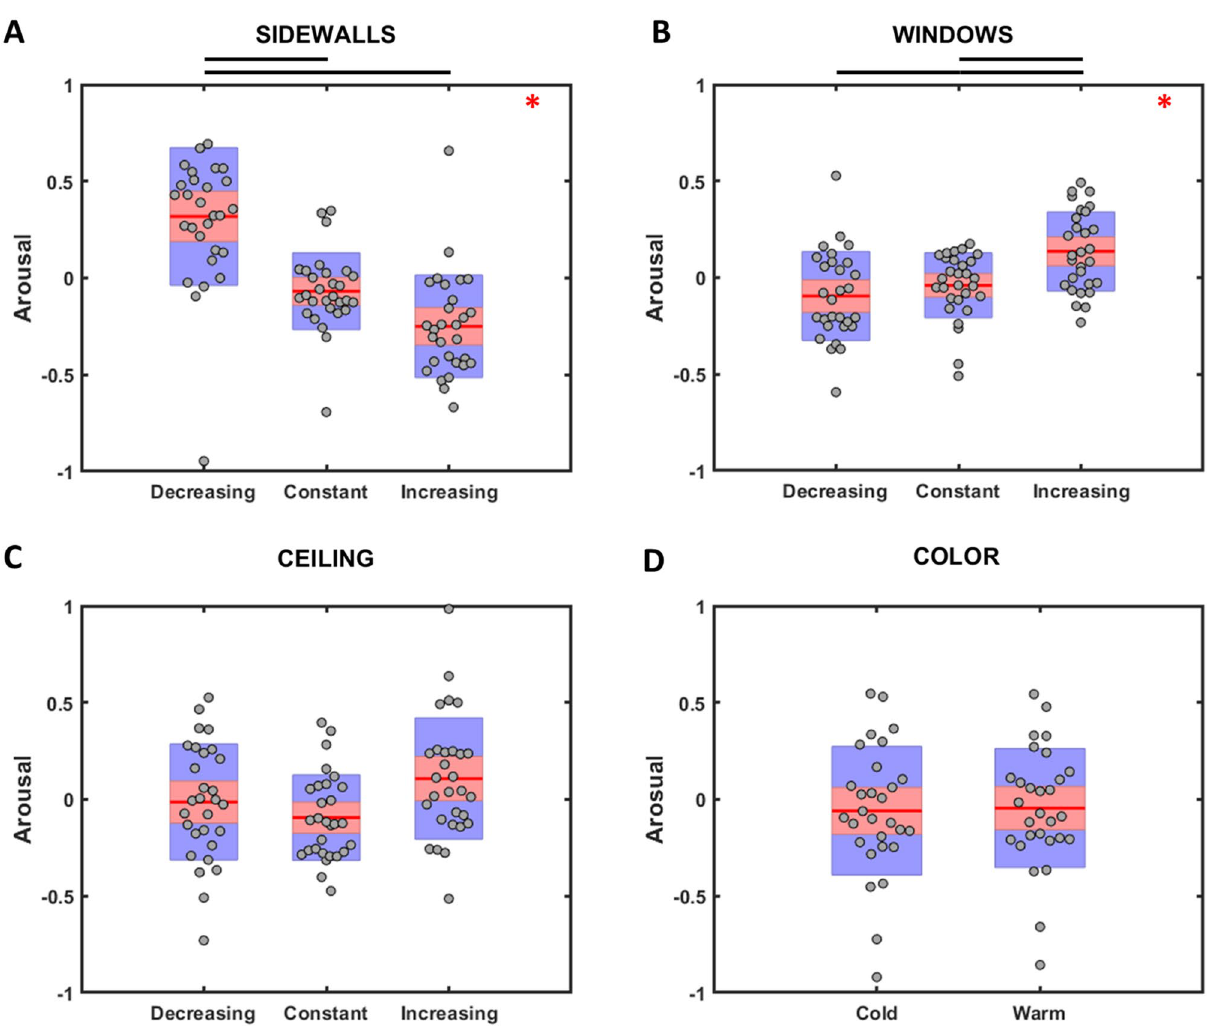
Figure 4. Distribution of arousal scores for the main factors SideWalls, Windows, Ceiling, and Color are presented in ( A – D ), respectively. Same color code as Fig.